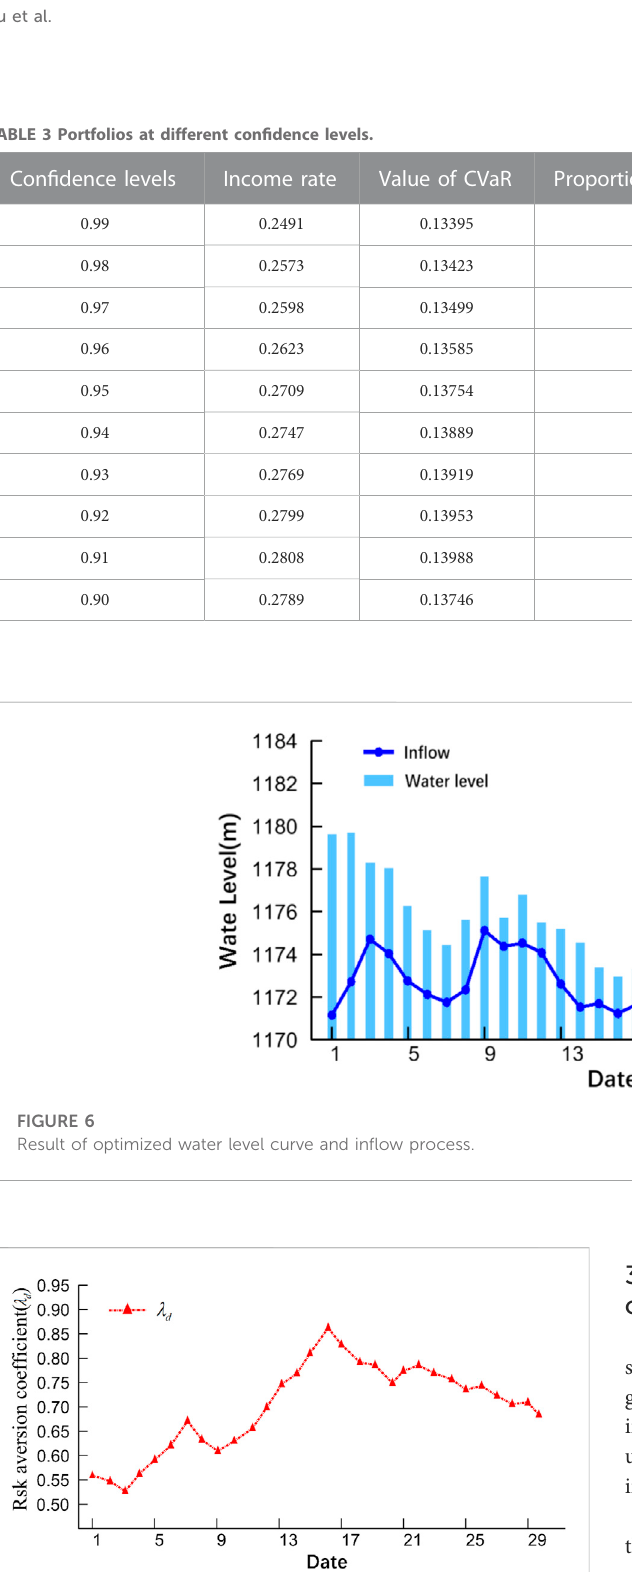
FIGURE 7 Risk aversion coef fi cient